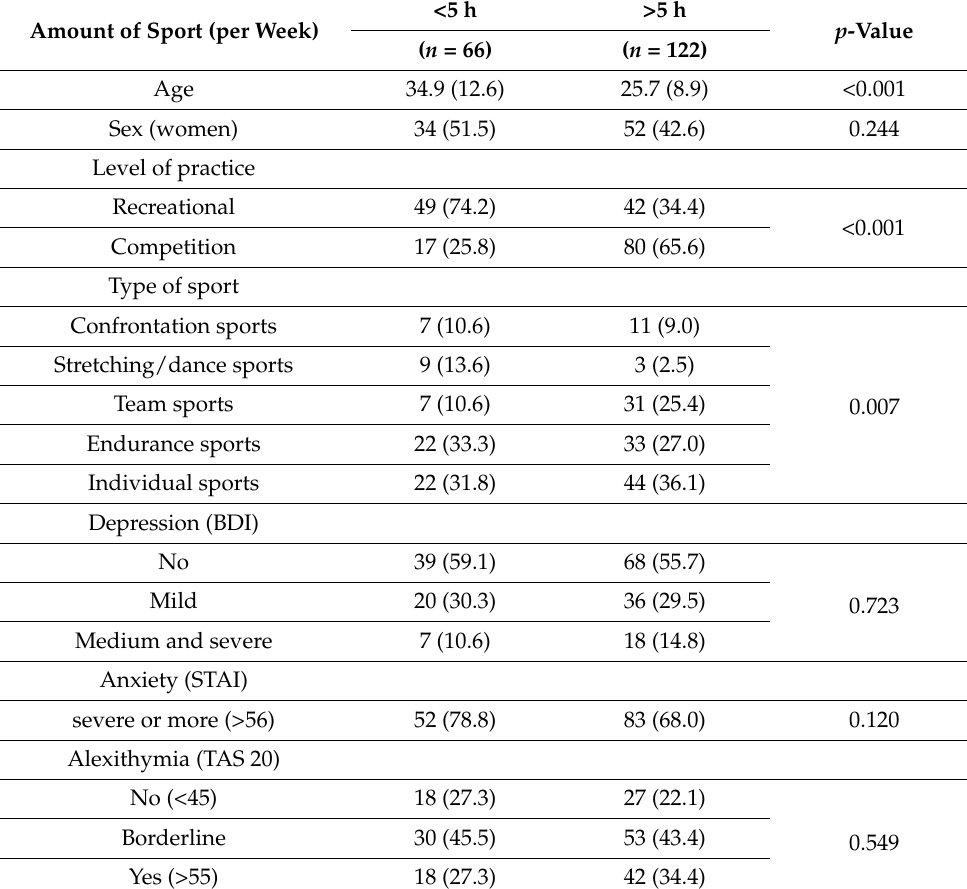
Table A1. Levels of depression, anxiety and alexithymia and type of sport comparing groups by